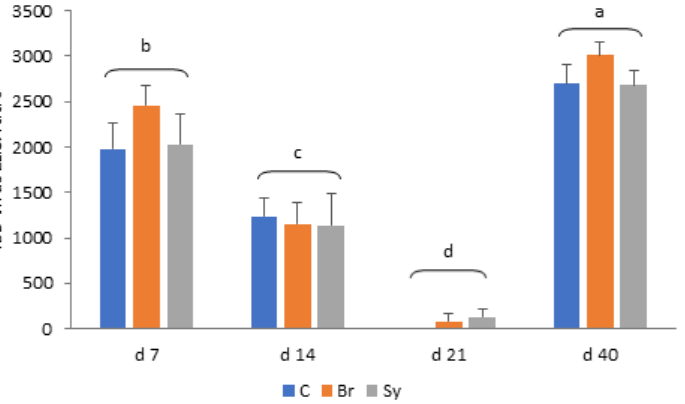
Figure 7. Infectious bursal disease (IBD) virus ELISA antibody titres in different treatment groups (mean ± SD). C—Control, Br—Broilact ® , Sy—Synbiotic feed additive; All p -values were